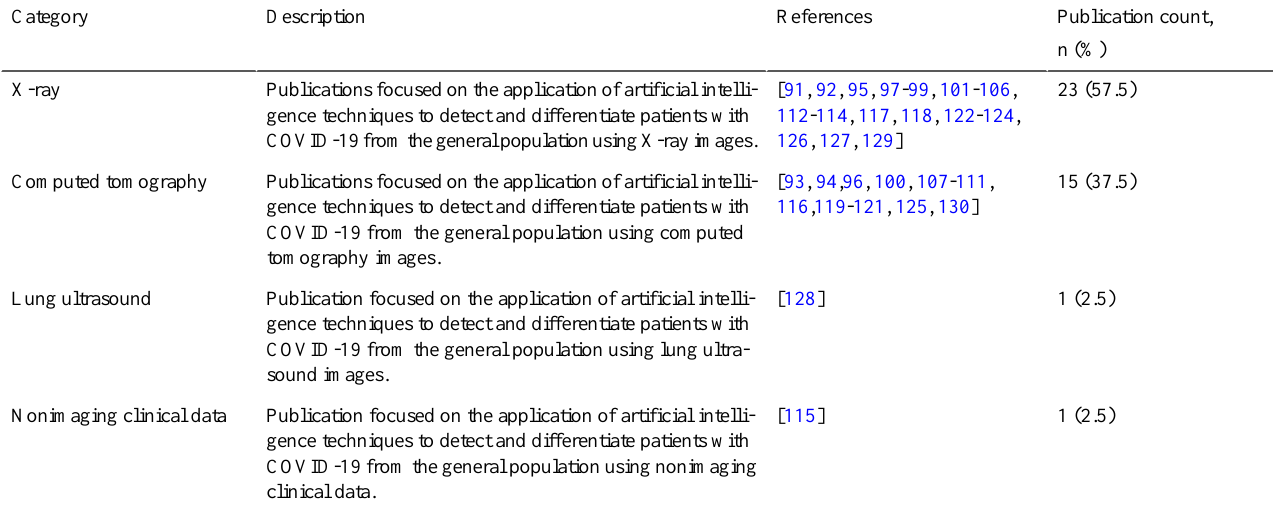
Table 3. Early Detection and Diagnosis publications (n=40) subclassified into 4 categories based on the modality used for COVID-19 prediction: (1) X-ray, (2) computed tomography, (3) lung ultrasound, and 4) nonimaging clinical